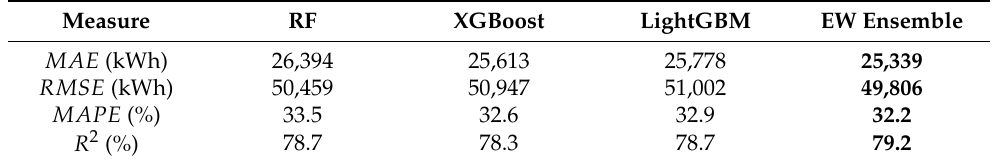
Table 3. Results on the test set. The top performing approach per measure is highlighted in boldface. Measure RF